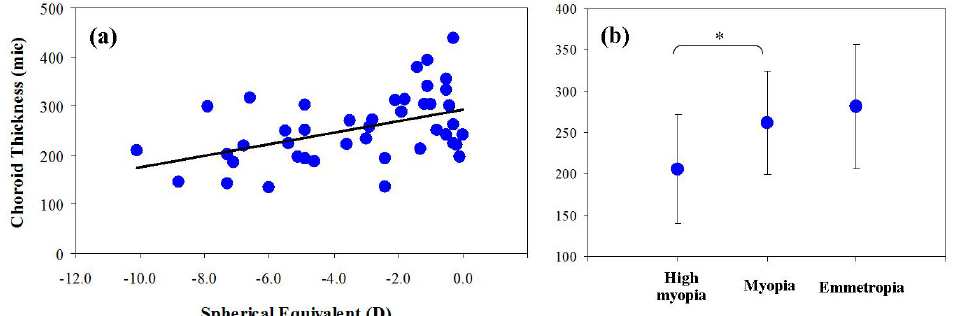
Figure 3. ( a ) Subfoveal choroidal thickness ( µ m) versus the SE. Best linear fit: Tcor = 11.66 · SE + 292.59. For each refraction value, the symbol represents the mean across three measurements (error bars were always within the blue dots). ( b ) Averaged thickness values for the experimental groups defined according to their refraction. Error bars indicate the standard deviation. (*: p = 0.03).